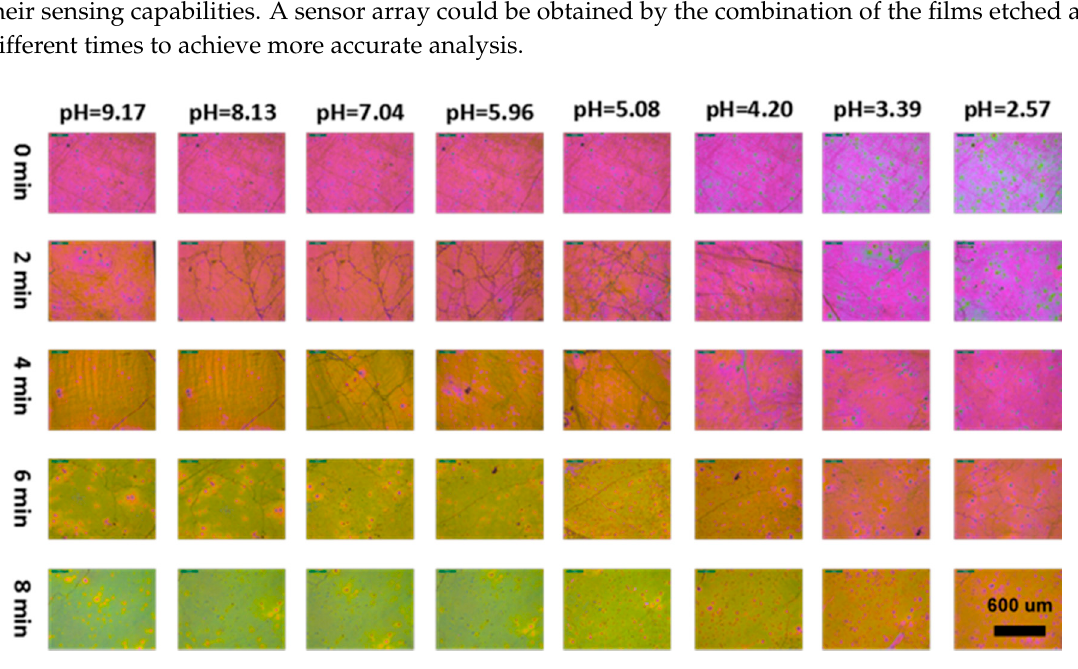
Figure 7. Optical micrographs showing the pH dependence of the different response colors of UPPGF-x (x = 0, 2, 4, 6, 8 min) (the size of each optical micrograph: 1.2 mm × 0.9 mm).